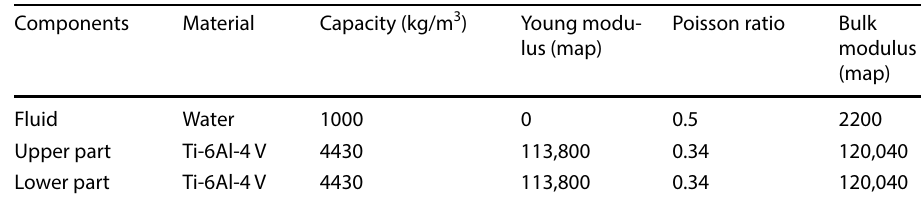
Table 6 Mechanical properties of diaphragm tank